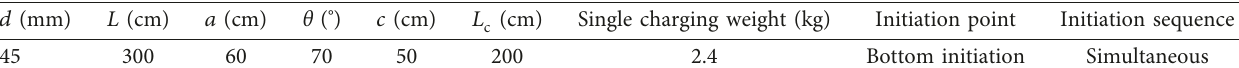
Figure 4: Borehole layout of the wedge cut (unit: cm). Table 2: Blasting parameters of the wedge cut.